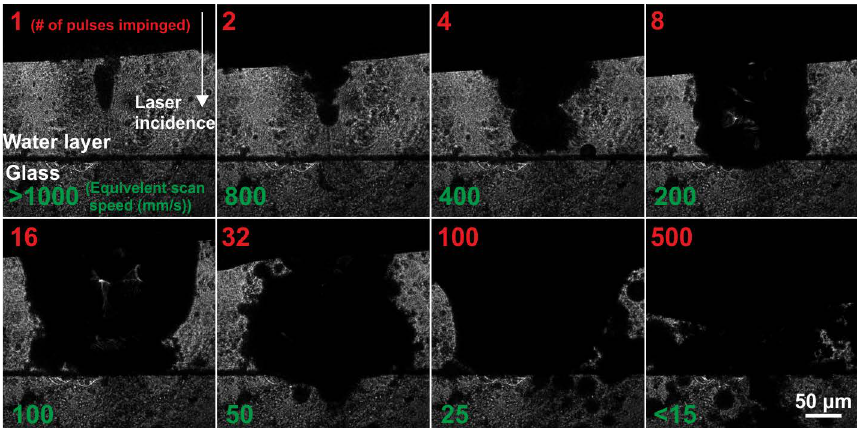
Figure 8. Shadowgraphic images acquired after a different number of impinging pulses on the surface. The top left number ( red ) shows the number of pulses required to obtain the image, the bottom left number ( in each image green ) represents the corresponding scanning speed. Laser repetition rate = 33.3